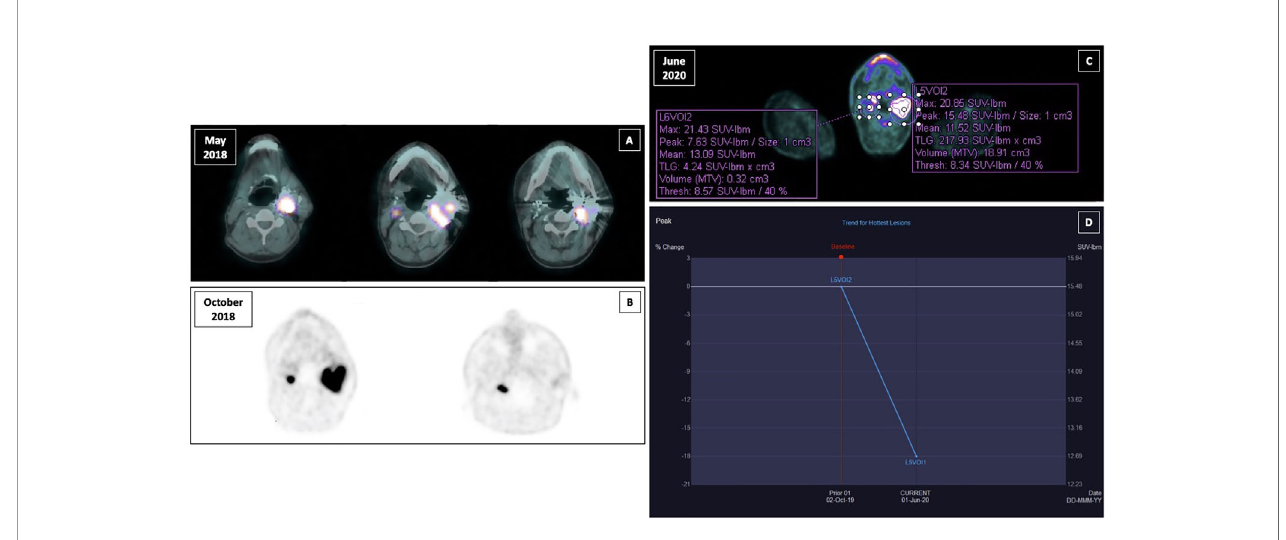
FIGURE 1 | Functional imaging of right and left paraganglioma and response to sunitinib treatment assesed by PERCIST criteria. (A) 18F- fl uoro- dihydroxyphenylalanine (18F-DOPA) positron emission tomography (PET)-computed tomography (CT) in May 2018; (B) 68Ga-DOTA-D-Phe1-Tyr3-Octreotate (68Ga- DOTATOC) PET-CT in October 2018; (C) 18F- fl uorodeoxyglucose (18F-FDG) positron emission tomography (PET)-computed tomography (CT) with contrast medium performed after the third cycle of therapy in June 2020; (D) peak standardized uptake value corrected for lean body mass (SULpeak) trend for the hottest